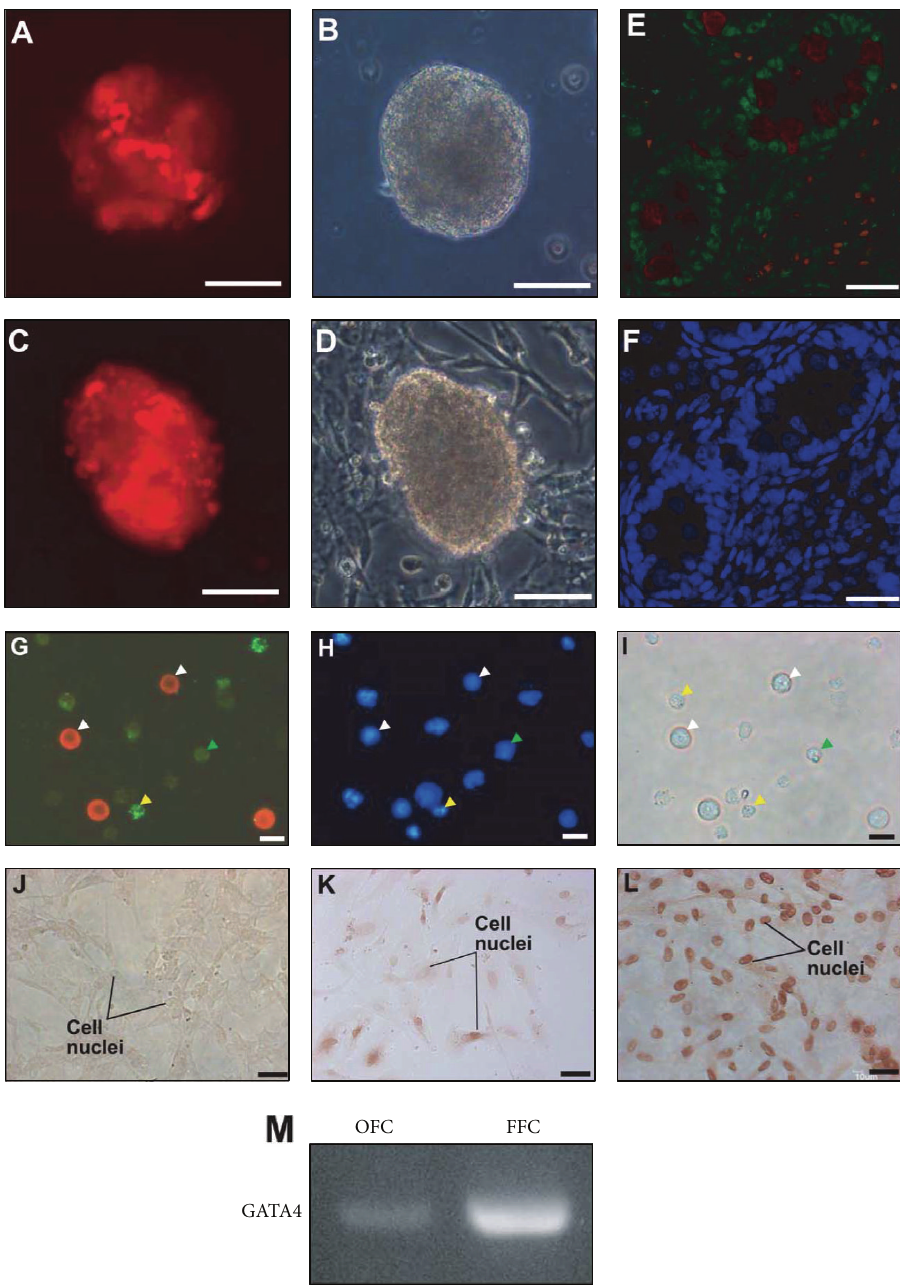
Figure 3: Maintenance of GATA4-positive feeder cells and germ cell-derived colonies (GDCs) in subculture at passages 1 and 10. GDC cells (labeled red) in passages 1 and 10 were maintained in the colonies in passages 2 and 11 ((A) and (C)). Panels (B) and (D) are bright-field images of panels (A) and (C), respectively. GATA4 and PGP 9.5 double staining in neonatal pig testis tissue (E). Panel (F) shows nuclear staining of panel (E). Total testicular cells were stained with antibodies against GATA4 (green) and PGP 9.5 (red) (G). Nuclear staining and bright-field images are shown in panels (H) and (I). Panel (J) shows negative controls on feeder cells attached to the wells. Panels (K) and (L) show GATA4 staining of old feeder cells (OFCs) and fresh feeder cells (FFCs), respectively, in passage 2. White and yellow arrows indicate PGP 9.5- and GATA4-positive cells, respectively; green arrows indicate PGP 9.5- and GATA4-negative cells. Scale bars indicate 50 𝜇 m in panels (A)–(F) and 10 𝜇 m in panels (G)–(L). Panel (M) shows PCR results for GATA4 in OFCs and FFCs in passage